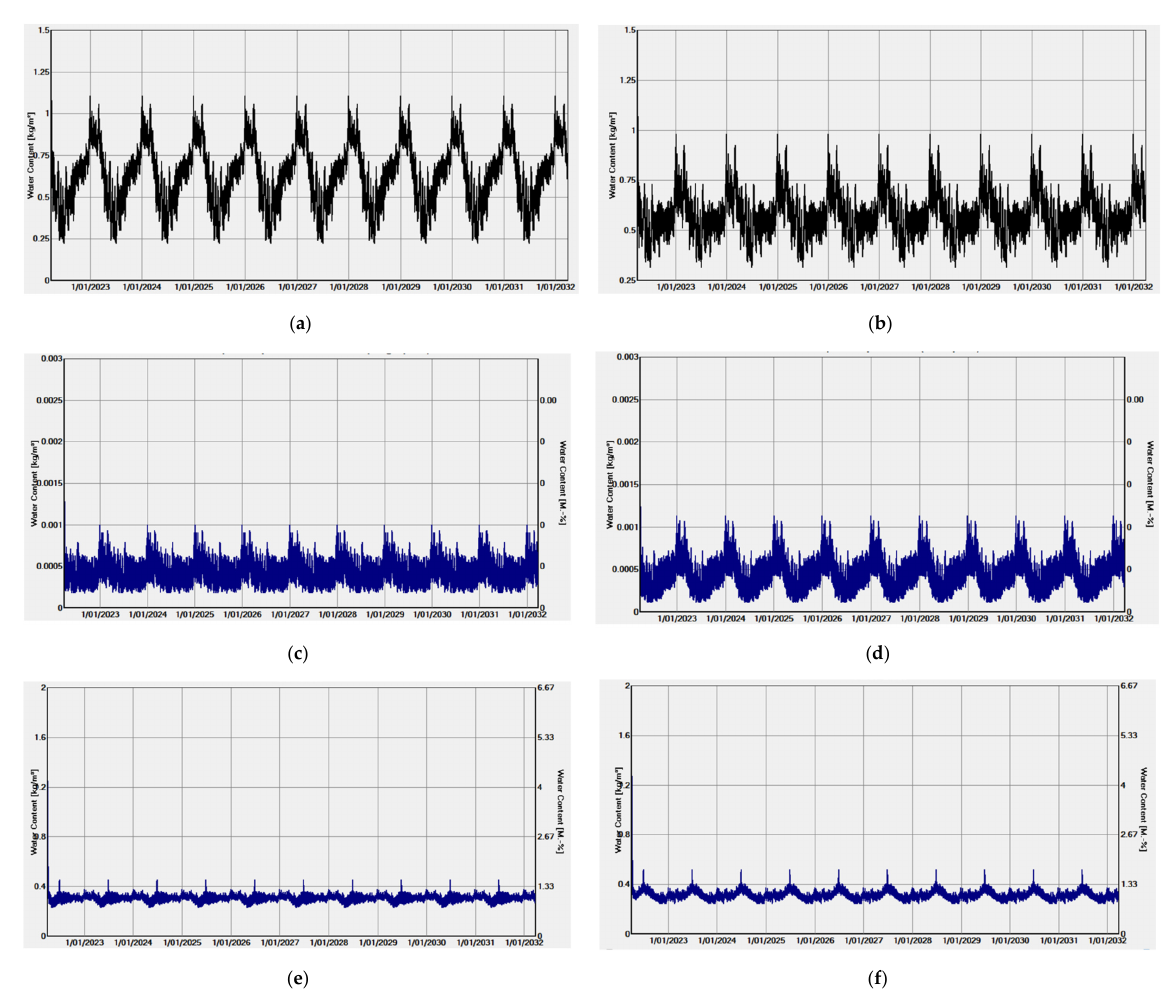
Figure 10. ( a – f ): Selected result of the moisture content for Pliable C, D, and E for Darwin. ( a ): Total moisture content of the wall assembly in northern orientation when either single or multipoint water vapour resistivity values of pliable membrane C, D, and E. ( b ): Total moisture content of the wall assembly in western orientation when either single or multipoint water vapour resistivity values of pliable membrane C, D, and E. ( c ): Moisture content of the vapour control layer in northern orientation for pliable membrane C, D, and E with both single and multipoint water vapour resistivity values. ( d ): Moisture content of the vapour control layer in western orientation for pliable membrane C, D, and E with both single and multipoint water vapour resistivity values. ( e ): Insulation, fibre glass (single point). ( f ): Insulation, fibre glass (multipoint).